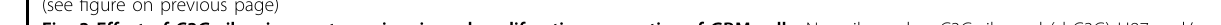
Fig. 3 Effect of C3G silencing on tumorigenic and proliferative properties of GBM cells. Non-silenced or C3G-silenced (shC3G) U87 and/or 12 Ф 12D cells have been used. A Anchorage-dependent growth assay in U87 cells. Left panel, representative phase-contrast microscopy images of a macroscopic view of foci (upper images) and an individual focus (lower images); right panel, histogram showing the mean value ± S.E.M. of the total foci number (upper panel) or number of cells per focus (lower panel) ( n = 5). B and C Anchorage-independent growth assays in U87 and 12 Ф 12D cells. Left panels, representative phase-contrast microscopy images of a macroscopic view of foci (upper images), cell organization in an individual focus (middle ( B ) or lower ( C ) images) and nuclei staining with DAPI ( blue ) (B lower panels). Dashed line indicates that DAPI stained nuclei images correspond to an independent experiment. Right panels, histograms showing the mean value ± S.E.M. of the foci number per fi eld (upper) or number of cells per focus (lower) ( n = 3 – 4). ( D ) Cell cycle analysis by cytometry of cells maintained in the presence of 10% FBS under adherent or non- adherent conditions (6 h). Histogram represents the percentage of cells in S and G2/M phases of cell cycle ± S.E.M. ( n = 2 – 6). * p ≤ 0.05, ** p ≤ 0.01, *** p ≤ 0.001, C3G silenced as compared to non-silenced cells under the same experimental condition. ( E ) Ki67 ( red ) staining in adhered U87 cells. Nuclei were stained with DAPI ( blue ). Left panel, representative microscope images; right panel, histogram showing the mean value ± S.E.M. of the percentage of Ki67 positive cells ( n = 3). * p ≤ 0.05 as compared to non-silenced cells. Scale bars: 100 µm (A, B, C and